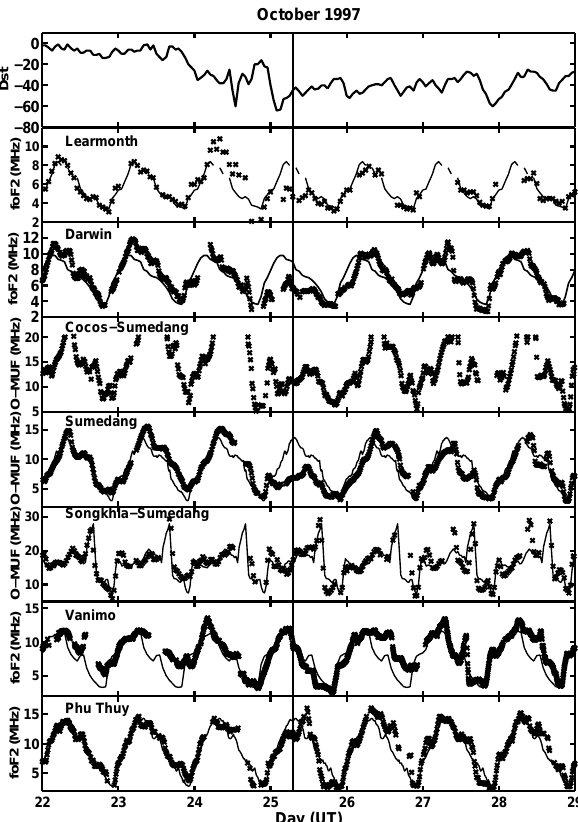
Fig. 5. D st , observed fo F2 and maximum oblique-path o-ray fre- quency values (crosses) and associated medians (line) for the period 22–29 October 1997. The TOPEX/Poseidon pass on the negative ionospheric storm day of 25 October is also shown (vertical